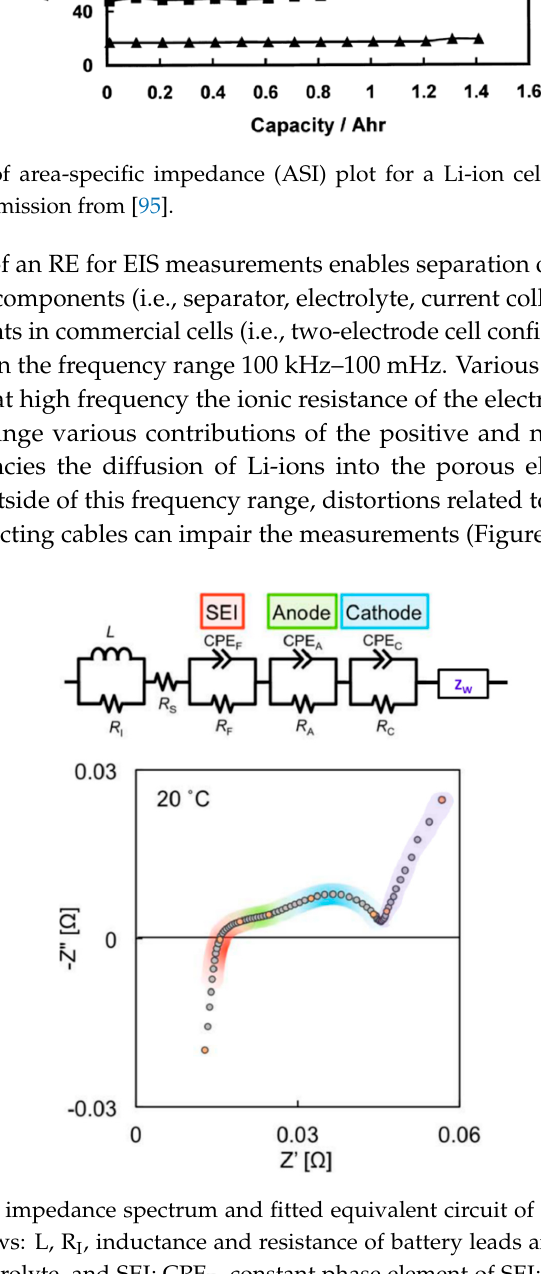
and Z W , Warburg diffusion through porous electrode structures. Figure adapted with permission from